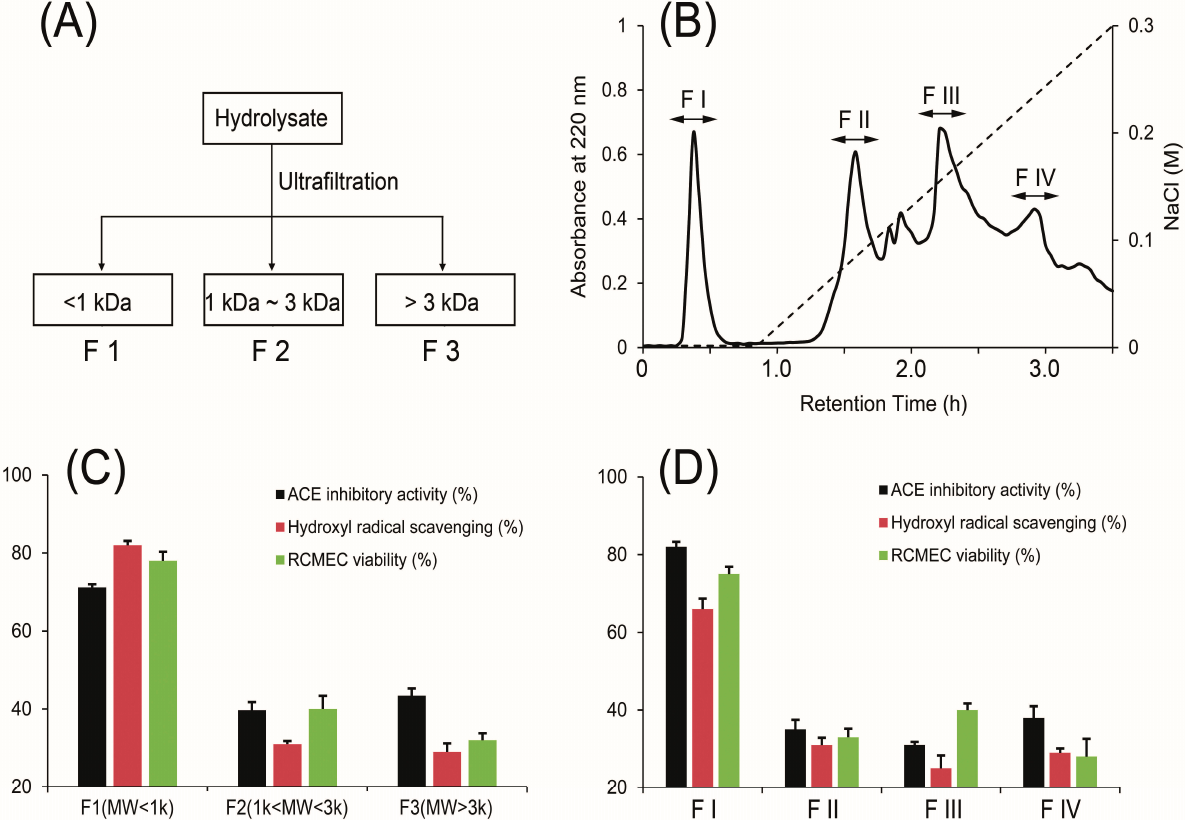
O ) of F I, F II, F III and 2 2